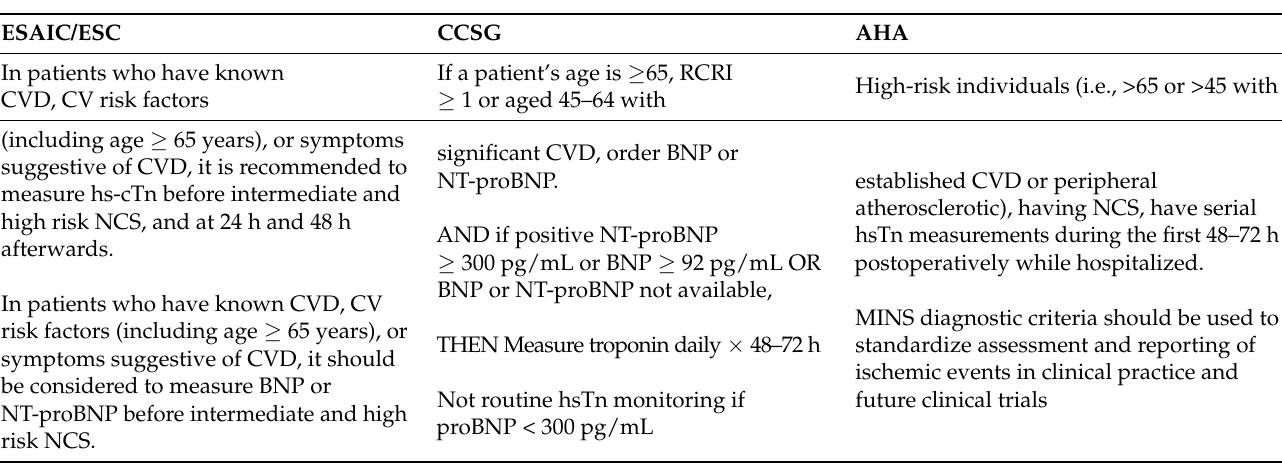
Table 4. Summary of recommendations from the European Society of Anesthesiology and Intensive Care (ESAIC), the European Society of Cardiology (ESC), the Canadian Cardiovascular Society Guidelines (CCSG), and the American Heart Association